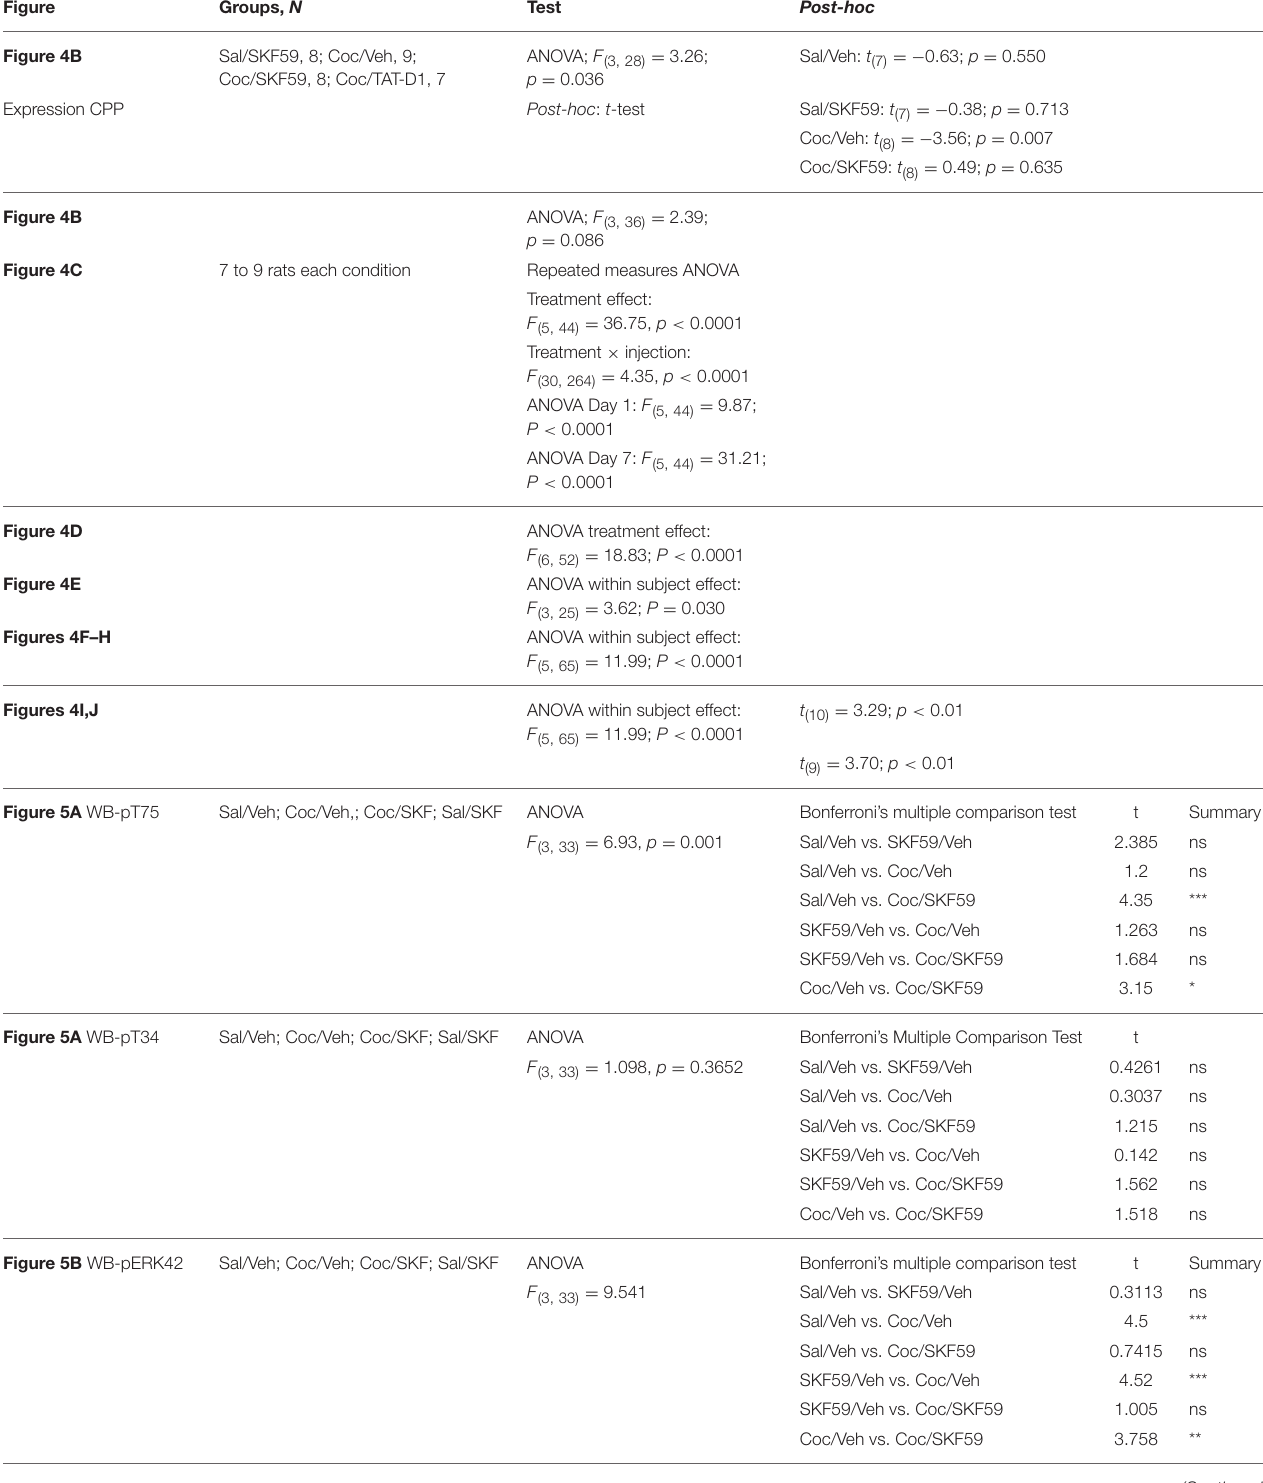
ANOVA; F (3, 28) = 3.26; Sal/Veh: t (7) = − 0.63; p = 0.550 p = 0.036